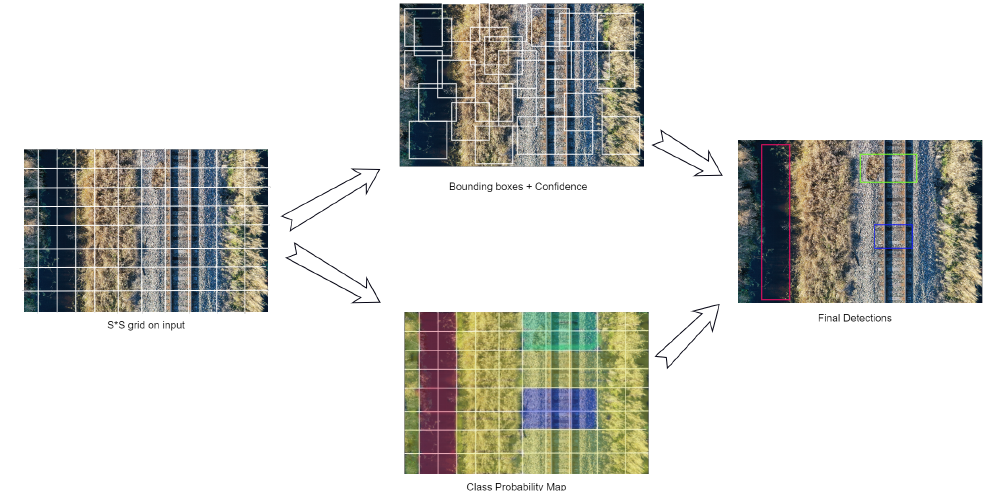
Figure 2. Bounding boxes creation with YOLO.